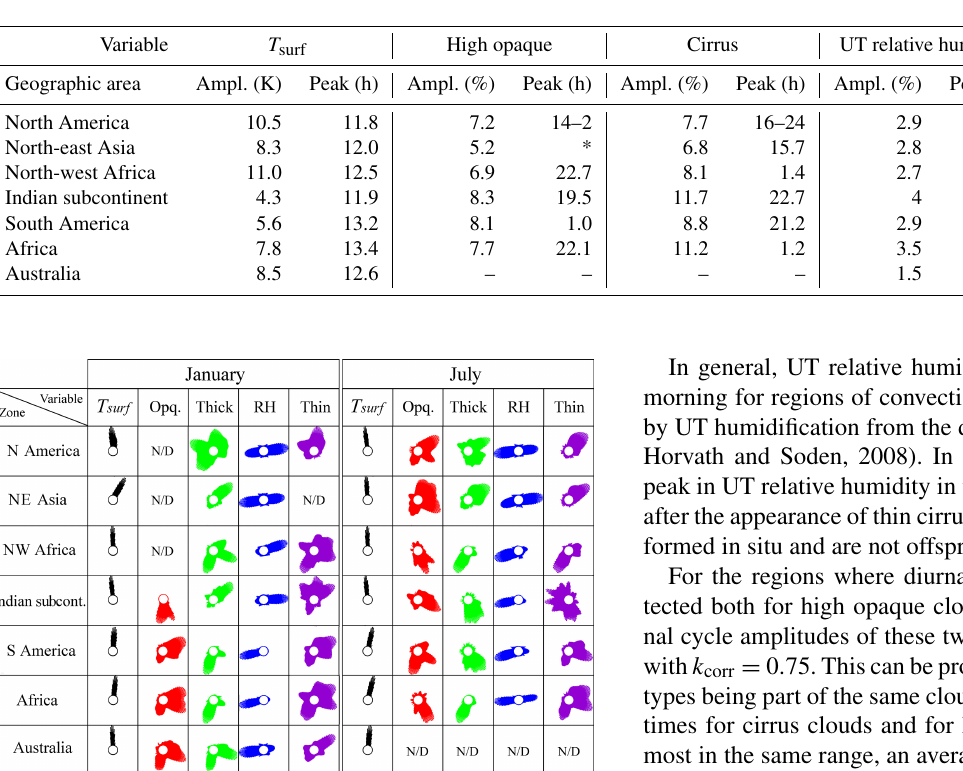
Table 2. Same as Table 1, but for average July.